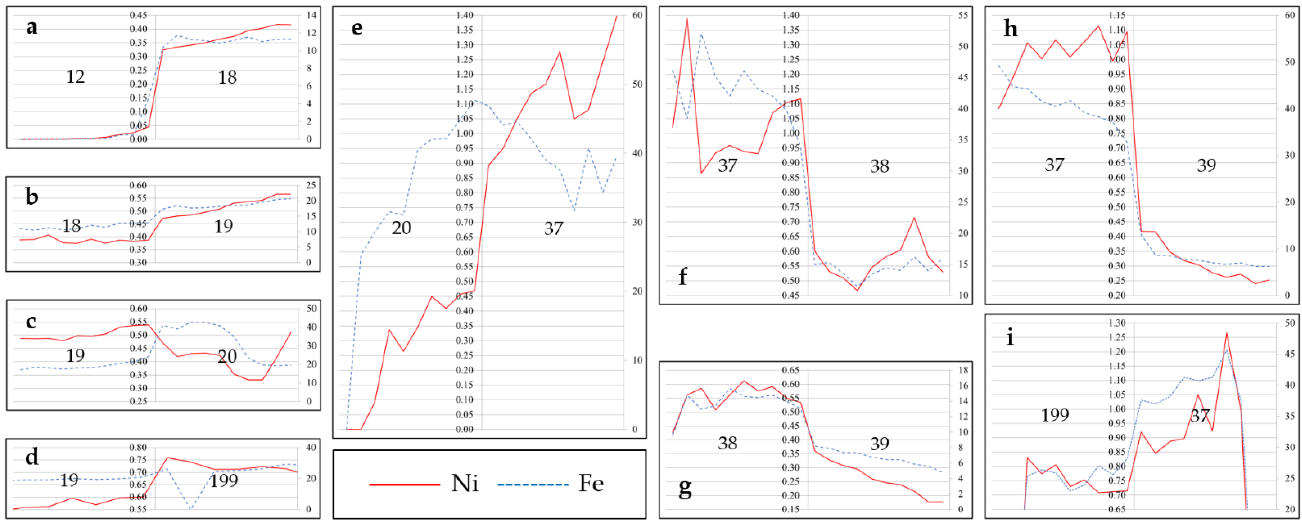
Figure 4. Contact profile graphs between various domains of the Tsouka deposit. The middle vertical axis shows mean Ni% grades of distance intervals on either side of the contact, while the right vertical axis shows corresponding mean Fe% grades. The horizontal axis starts and ends 10 m before and after the boundary between the two domains.